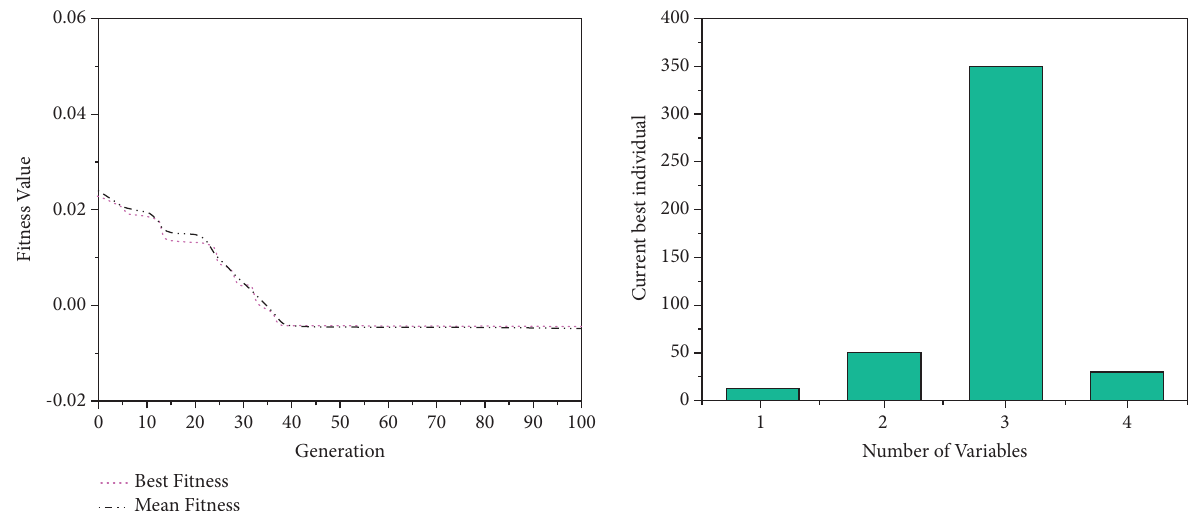
Figure 8: Best and mean values of output results of the erosion wear